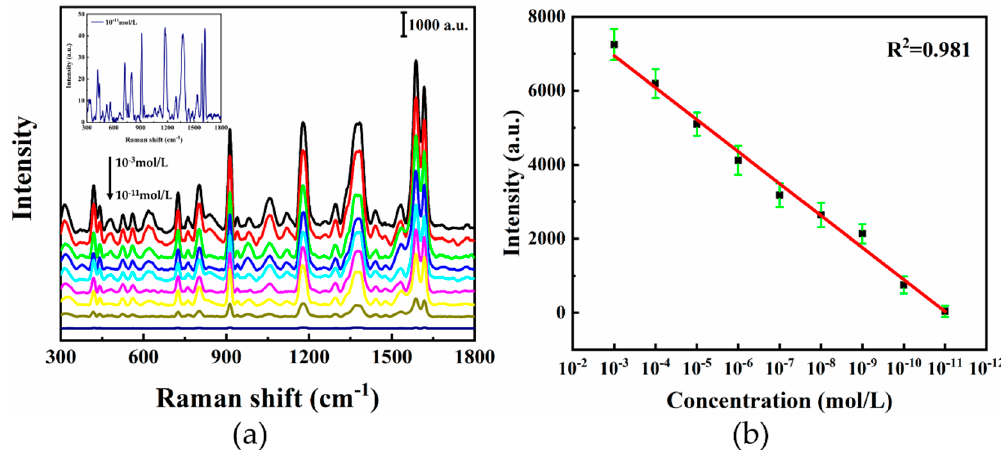
Figure 5. ( a ) SERS spectra of CV with the concentration decreased from 10 − 3 to 10 − 11 mol / L. Inset shows the detailed view of SERS spectra of CV at 10 − 11 mol / L; ( b ) plot of Raman intensities for CV at 1583 cm − 1 with different concentrations.